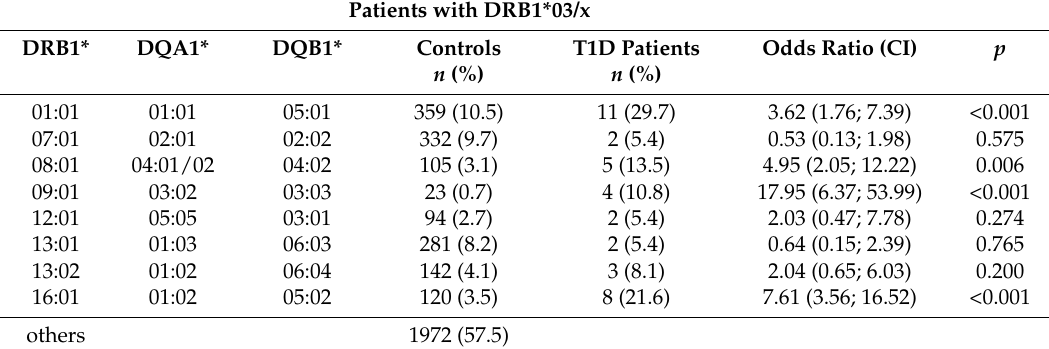
Table 2. Analysis of the DRB1-DQA1-DQB1 second alleles in heterozygous DRB1*03/x (DR3-DQ2) and HLA DRB1*04/x (DR4-DQ8) patient and controls, carrying one high-risk allele. Data were separately analysed for HLA DRB1*03/x (DR3-DQ2) and DRB1*04/x (DR4/DQ8) heterozygous